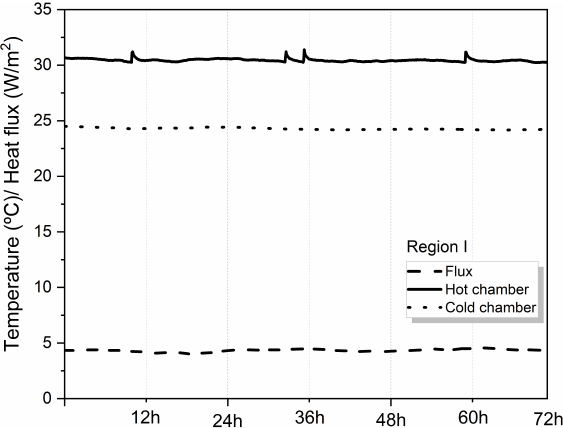
Figure 6. Region II reed board prototype: tempera- tures and heat flow.